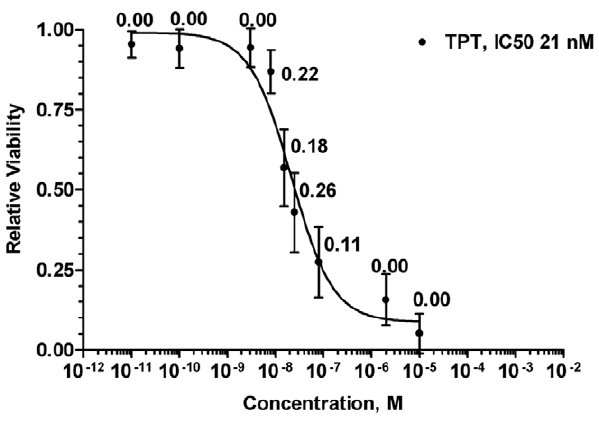
Figure 1. Representative dose–response curve for camptothe- cin analogues. Data points represent the overall population mean (n=126) for growth inhibition relative to untreated controls at each concentration of topotecan. Vertical bars represent the standard deviation for cell viability across the population. Numbers are the growth-rate adjusted heritability estimates for each concentration. IC50 represents overall population IC50.